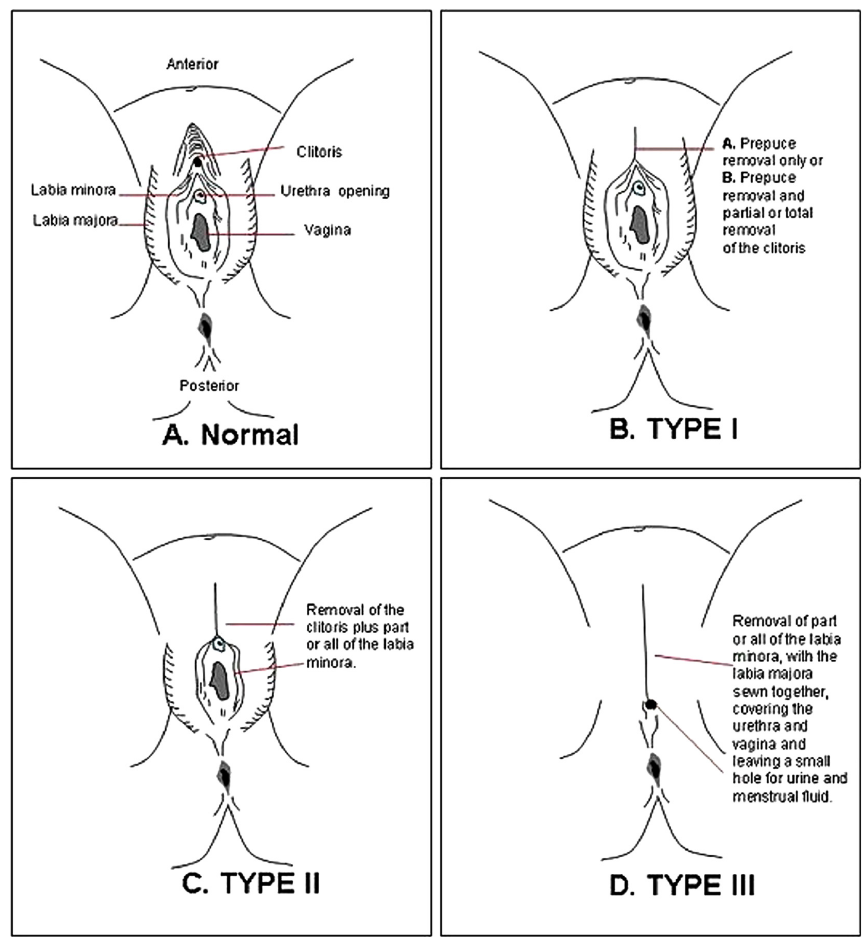
Figure 1. Images illustrating different types of female genital mutilation. Source: